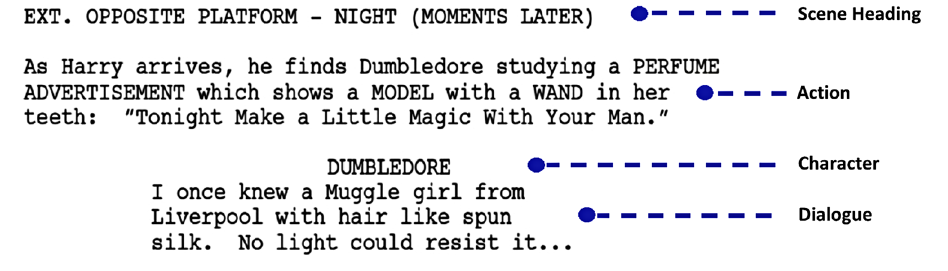
Fig. 3 Standard movie script format. The way movie scripts are typically composed.